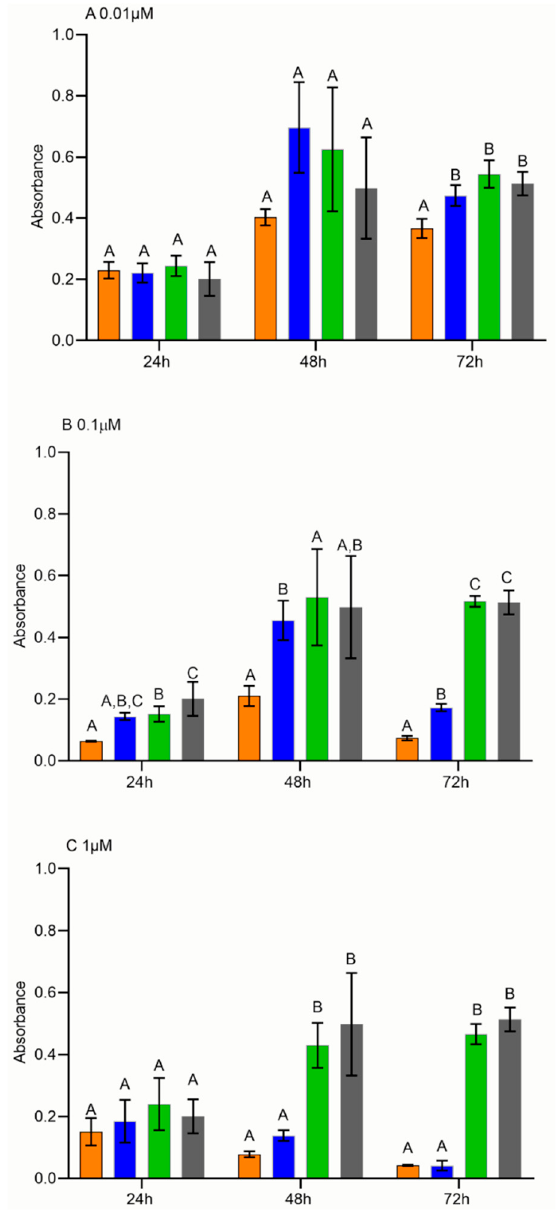
Figure 7. Cell proliferation assay. Proliferation assay on FMCm treated with engineered ferritin nanocage loaded with doxorubicin (HFn(DOX)) (orange), DOX alone (blue), HFn alone (green), and Roswell Park Memorial Institute (RPMI) (gray), at three different concentrations and three different time points: ( A ) proliferation assay at 0.01 µM; ( B ) proliferation assay at 0.1 µM; ( C ) proliferation assay at 1 µM. Cells treated with HFn(DOX) proliferated less than cells treated with DOX alone at 0.01 µM at 72 h post treatment ( p < 0.05) ( A ) and at 0.1 µM after both 72 h and 48 h (B) ( p < 0.05).